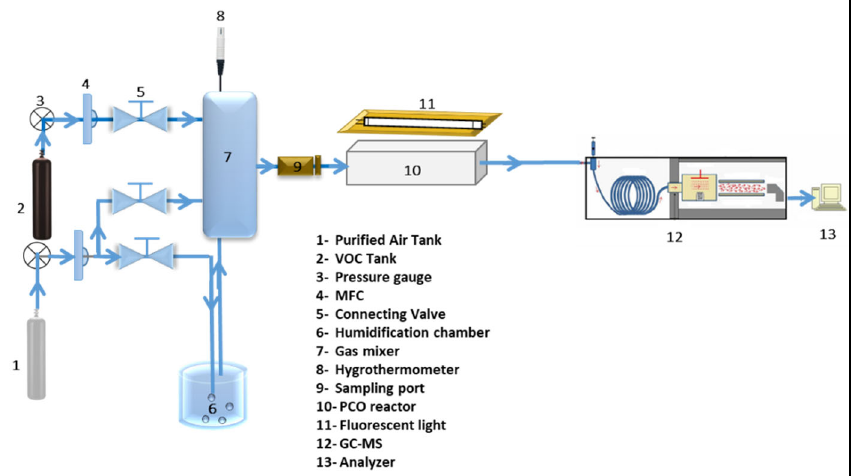
Figure 10. Schematic diagram of PCO reactor.